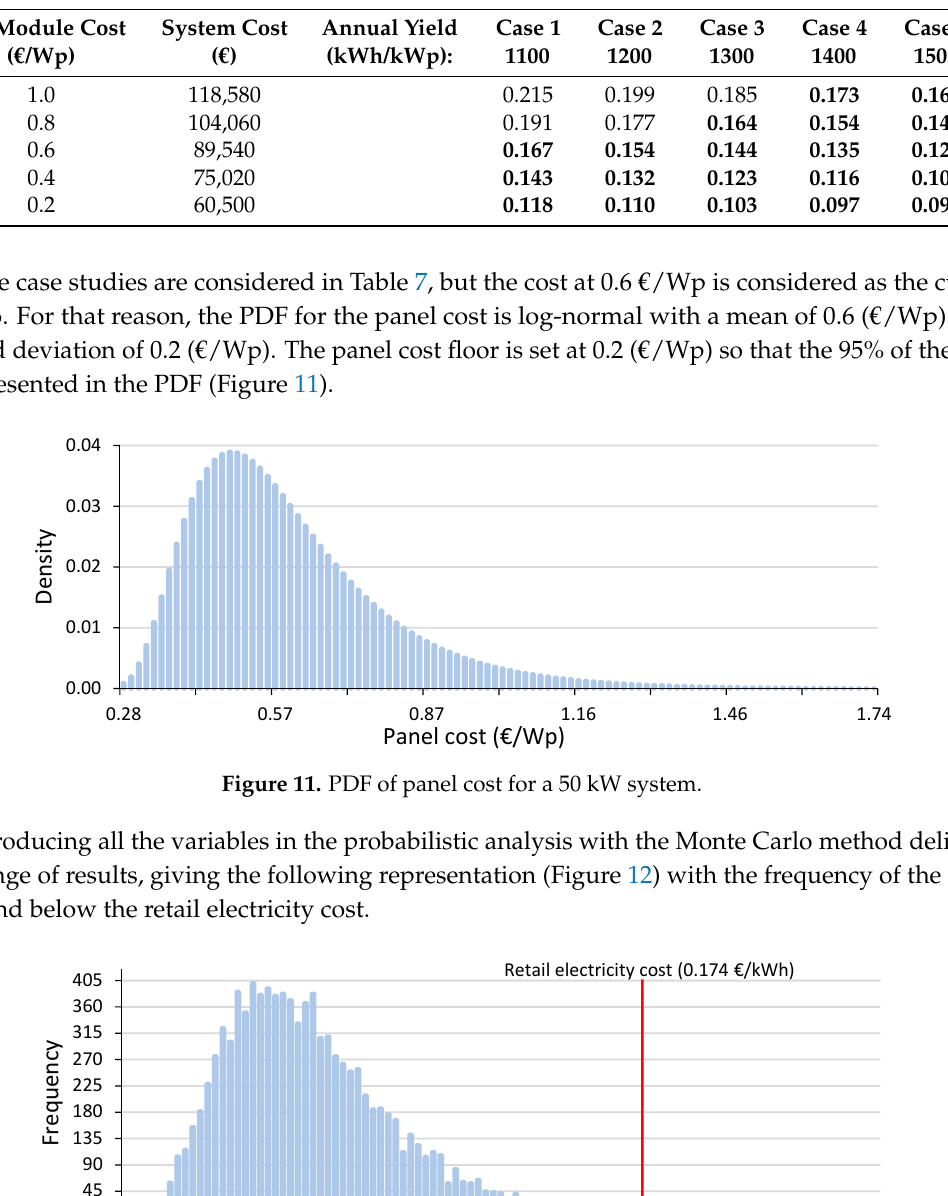
Figure 13. Histogram of the IRR calculated with the Monte Carlo method for a 50 kW system. A success rate parameter (%) is introduced by counting the number of iteration results below the retail cost of the electricity and dividing by the total number of iterations (10,000). Analysing the